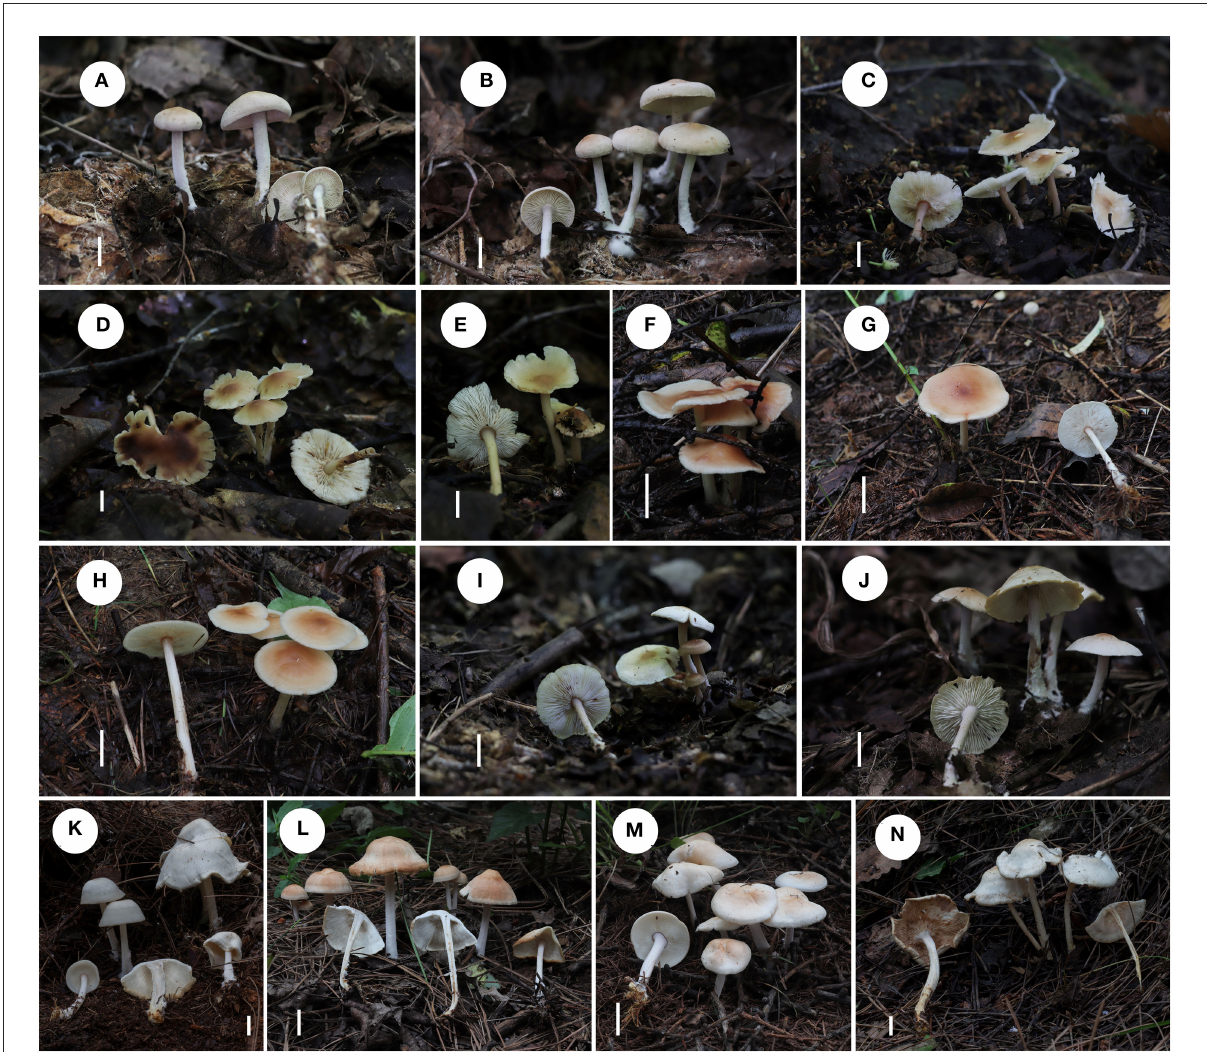
FIGURE2 Fresh basidiomata of Gymnopus species. (A,B) Gymnopus epiphyllus ; (C–E) Gymnopus cystidiosus ; (F–H) Gymnopus subdensilamellatus ; (I,J) Gymnopus subpolyphyllus ; (K–N) Gymnopus densilamellatus . Scale bars: 1cm (A–N)